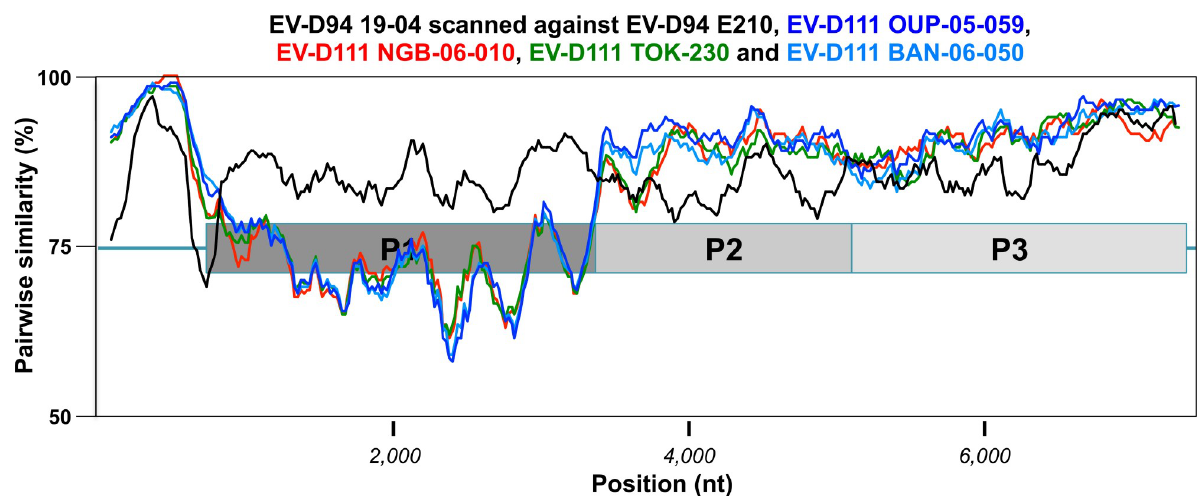
Fig 6. Comparative analysis of EV-D94 and EV-D111 full-length genomes. A similarity plot was drawn by comparing the genomic sequence of the strain EV-D94 19–04 with those of other EV-Ds.